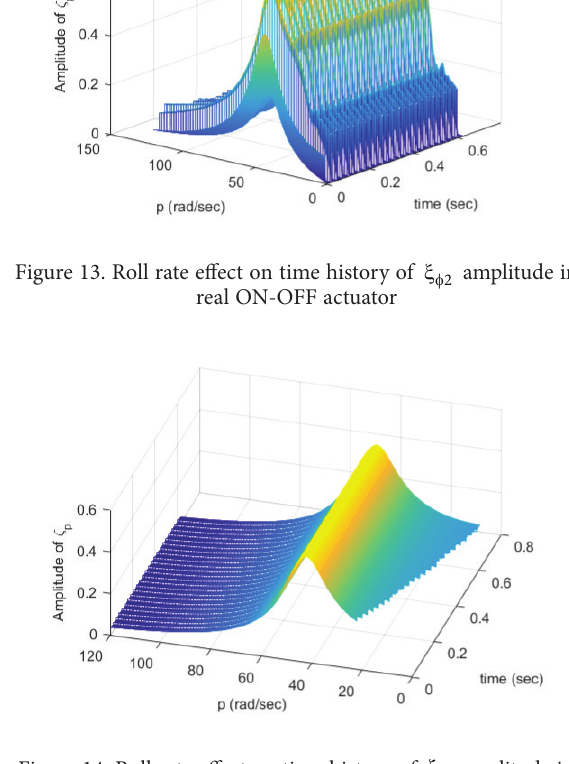
Figure 14. Roll rate eff ect on time history of p ξ amplitude in